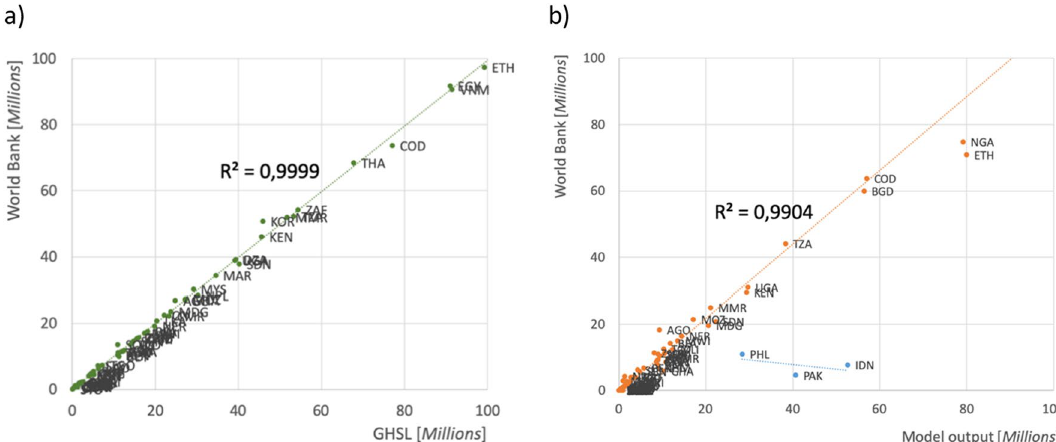
Figure 2. Statistical analysis of the spatial distribution data, by country. ( a ) Correlation between national- level data on total population 20 and data on population per cell from GHSL 16 . ( b ) Correlation between data on the size of the unelectrified population at the national level 20 . Indonesia, Pakistan, and the Philippines are not considered in the adjustment because of large discrepancies in the reported data on the unelectrified population (“Methods”). Sources: World Bank 20 ; Global Human Settlement Layer 16 ; Authors’ compilation based on the